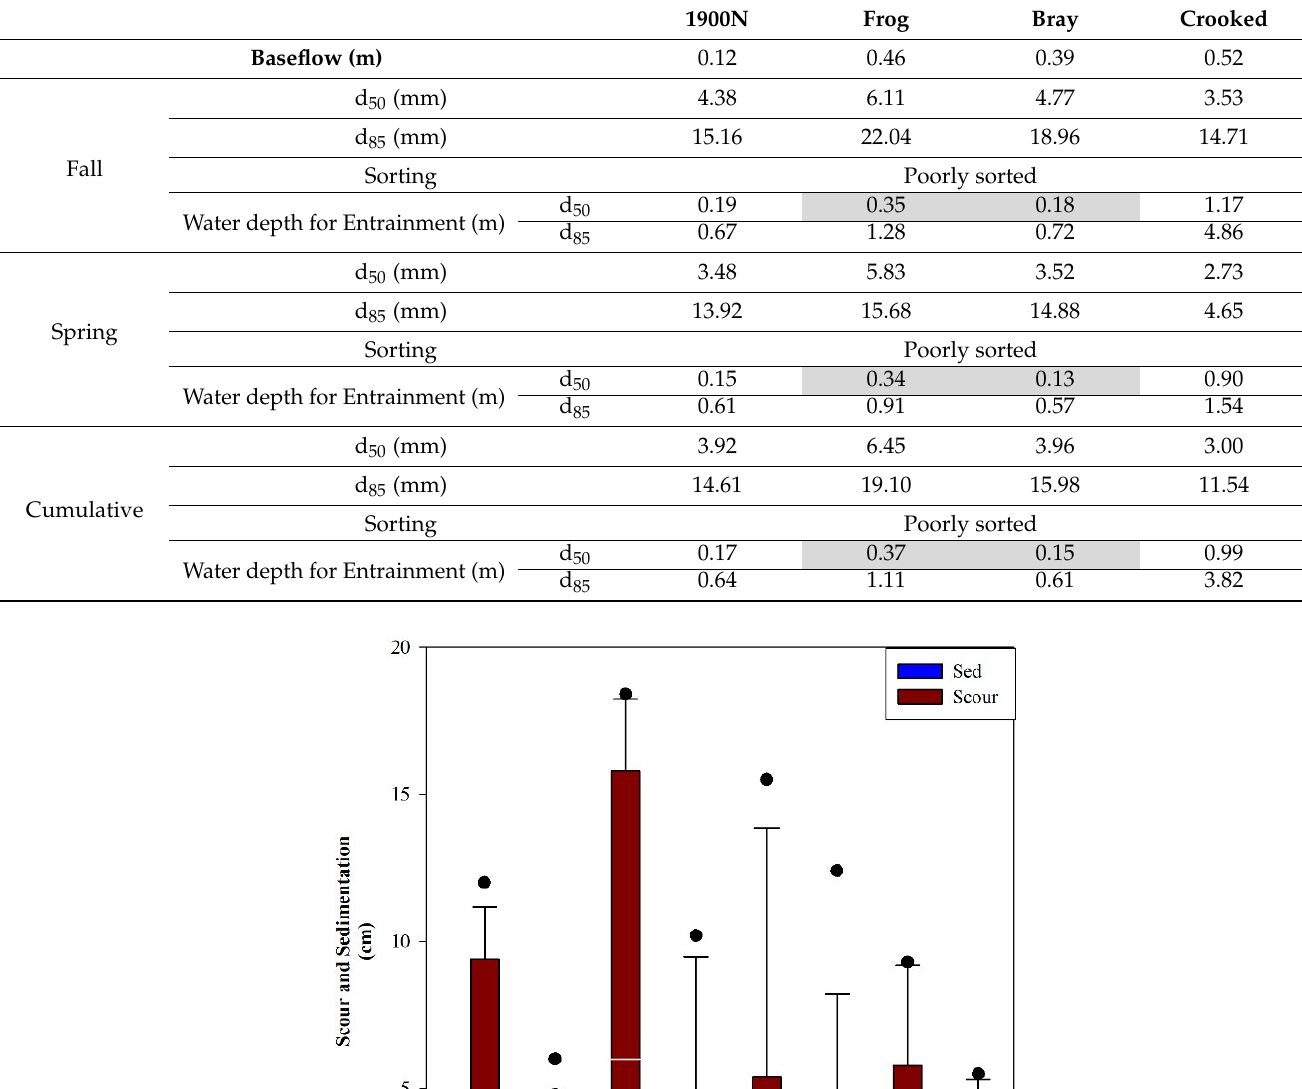
Table 2. Measured baseflow depths, d 50 and d 85 sizes, and calculated entrainment depths required to mobilize d 50 and d 85 sediments. Shaded cells highlight when the calculated entrainment depth was below the measured baseflow depth.